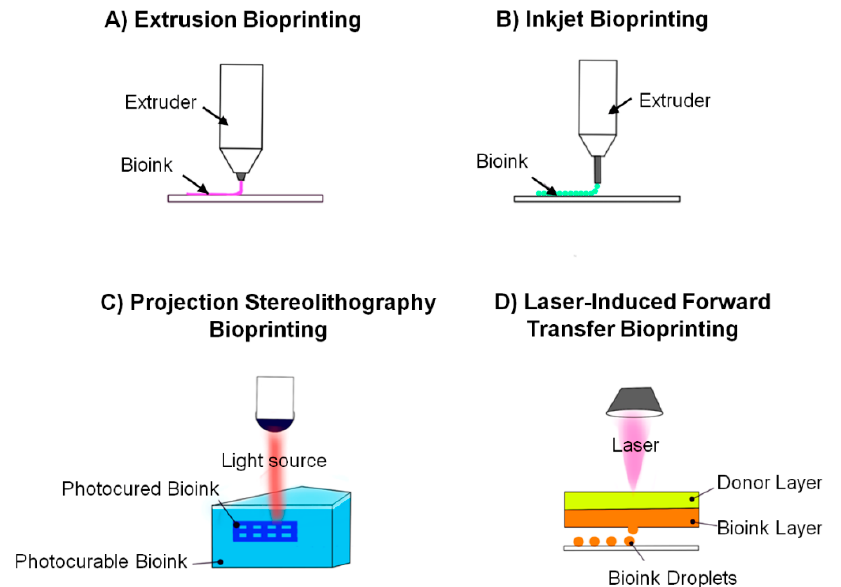
Figure 3. 3D bioprinting techniques. ( A ) Extrusion bioprinting: nozzle-based continuous layer-by-layer deposition of bioink using pneumatic pressure-, screw-, or pledged-based mechanisms. ( B ) Inkjet bioprinting: nozzle-based layer-by-layer deposition of bioink droplets using thermal